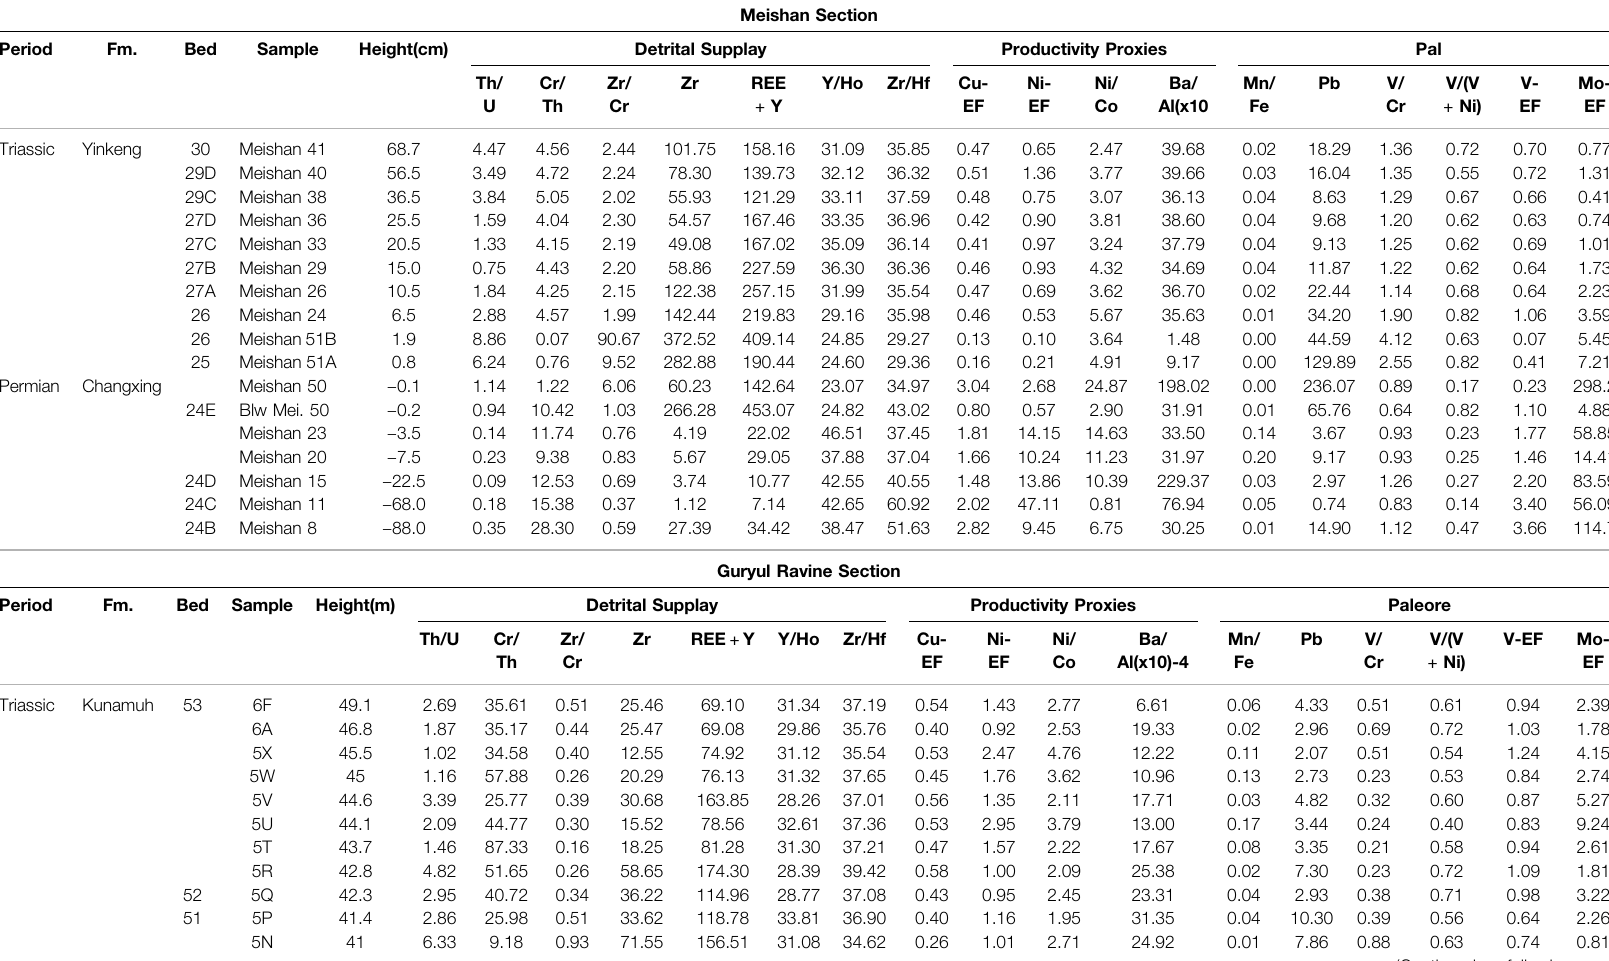
Meishan Section